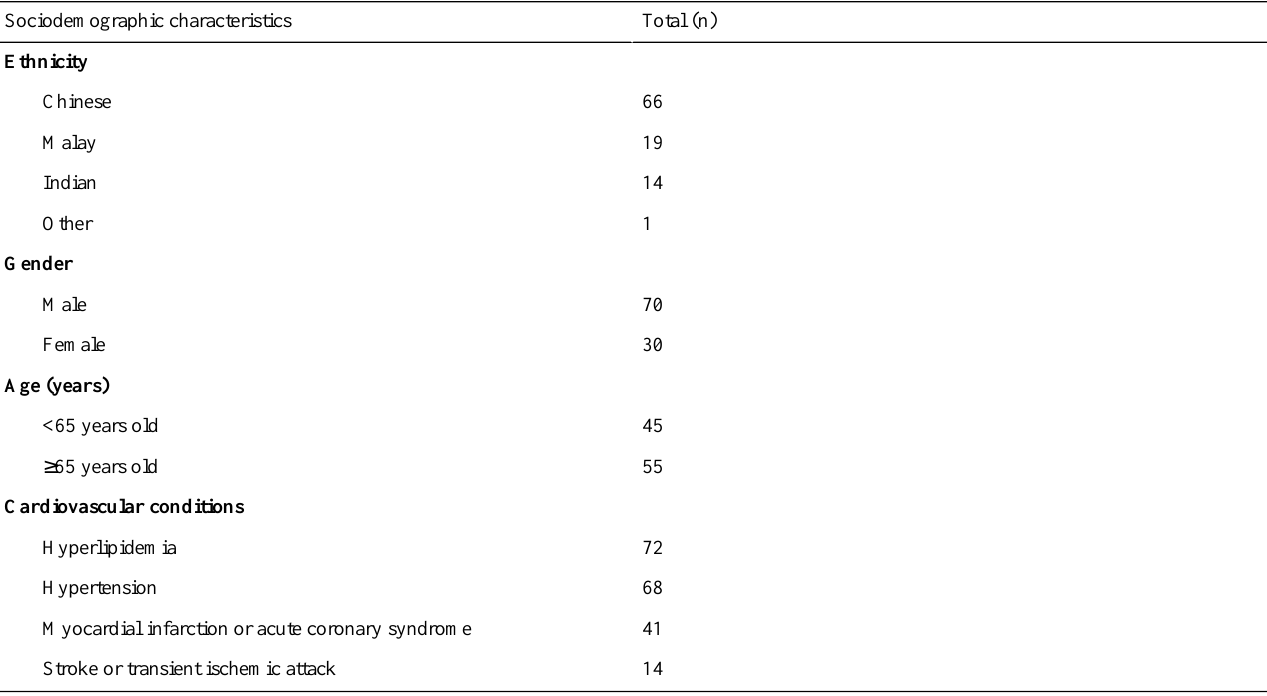
Table 1. Quantitative participant characteristics table (n=100).